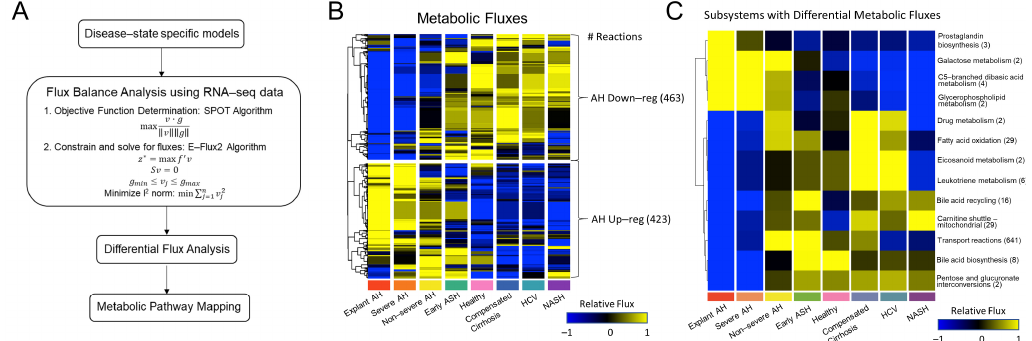
Figure 3. Predicted metabolic flux analysis for the generated GEMs. ( A ). Workflow describing flux balance analysis (FBA) calculations and downstream analysis. ( B ) Hierarchical clustering of metabolic fluxes identified two clusters: (1) AH Down-reg with 463 fluxes and (2) AH Up-reg with 423 fluxes. ( C ) Fluxes were averaged across subsystem and those differing significantly across models, as tested by Wilcoxon ranked sum test ( p < 0.05), are shown.